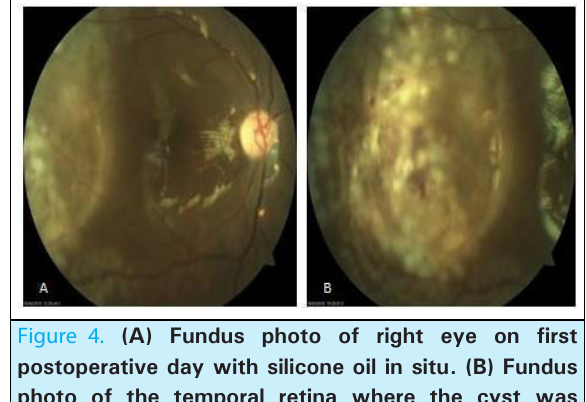
Figure 4. (A) Fundus photo of right eye on first postoperative day with silicone oil in situ. (B) Fundus photo of the temporal retina where the cyst was removed with whitish laser